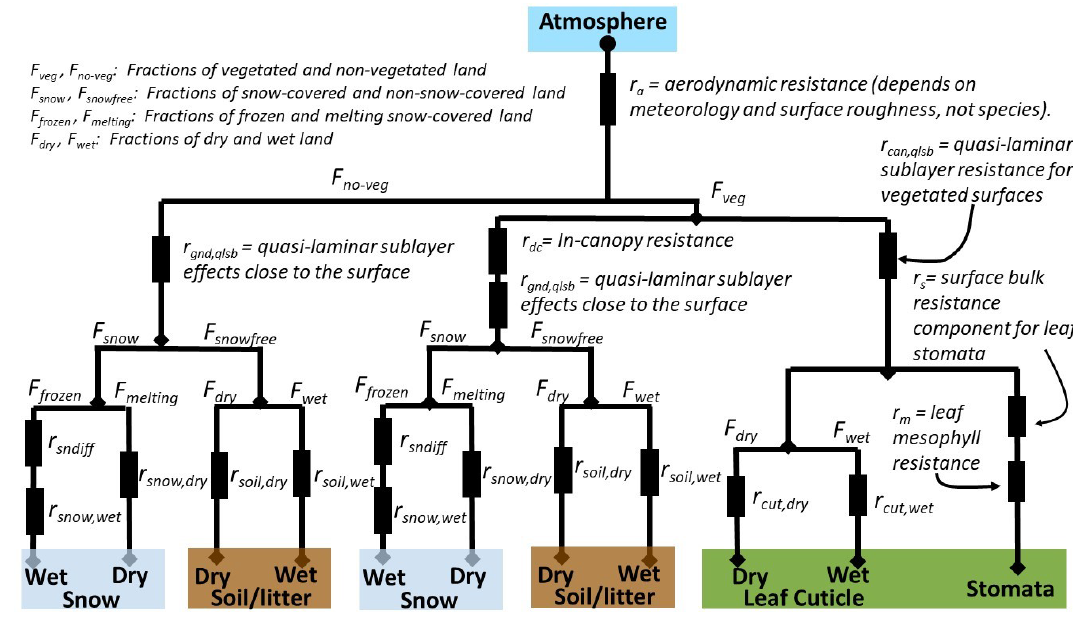
Figure B3. Resistance diagram for the U.S. EPA CMAQ model with the STAGE deposition option. Note that this is an extension of the Massad et al. (2010) and Nemitz et al. (2001) resistance model in the CMAQ modelling